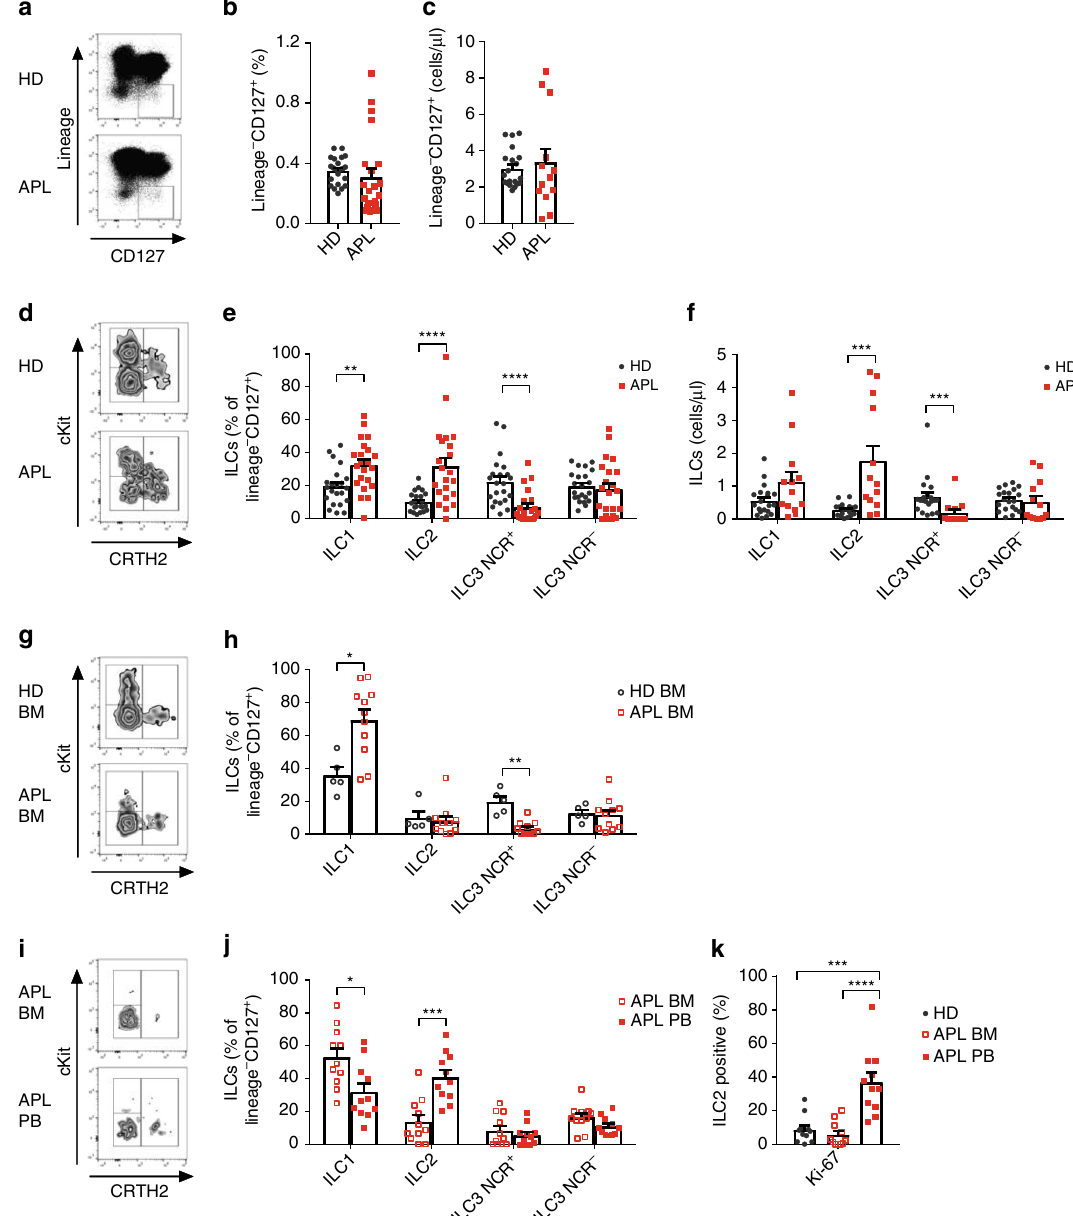
Fig. 1 ILC2 are signi fi cantly increased in human APL. a Representative examples of fl ow cytometry analysis of innate lymphoid cells (ILC) in healthy donors (HD) and APL patients ’ (APL) peripheral blood. HD were sex- and age-matched with APL patients, M:F 12:10 vs. 12:10, median age 45 vs. 43, min 27 vs. 23, max 72 vs. 77 years. b Frequencies ( n = 22) and c cell numbers/ µ l (HD n = 20, APL n = 13) of total ILCs identi fi ed as Lin − CD127 + cells in lymphocytes. d Representative examples of fl ow cytometry analysis of innate lymphoid cell subsets in HD and APL patients ’ (APL) peripheral blood. e Relative frequencies ( n = 22) f cell numbers/ µ l (HD n = 20, APL n = 13) of ILC subsets among total ILCs. g Representative examples of fl ow cytometry analysis of ILC subsets in the bone marrow of healthy donors (HD BM) and APL patients (APL BM). h Relative frequencies of ILC subsets among total ILCs (HD n = 5, APL n = 11). i Representative examples of fl ow cytometry analysis of ILC subsets in paired APL BM and peripheral blood (APL PB) samples of APL